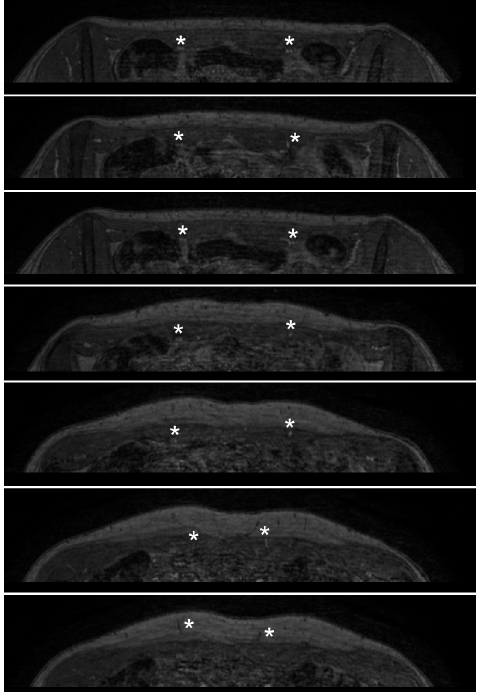
Figure 3. Transverse slices demonstrate the vascular bundle dorsal to the rectus muscle. Transverse source images of equilibrium-phase dataset in the same patient. Images are from caudal (top panel) to cranial (bottom panel), and clearly demonstrate the vascular bundle dorsal to the rectus muscle shortly after branching off the external iliac artery (asterisks in top three panels). The perforating branches can easily be followed when traversing the rectus muscle to the point where they arise in the subcutaneous fat (asterisks in lower 4 panels).